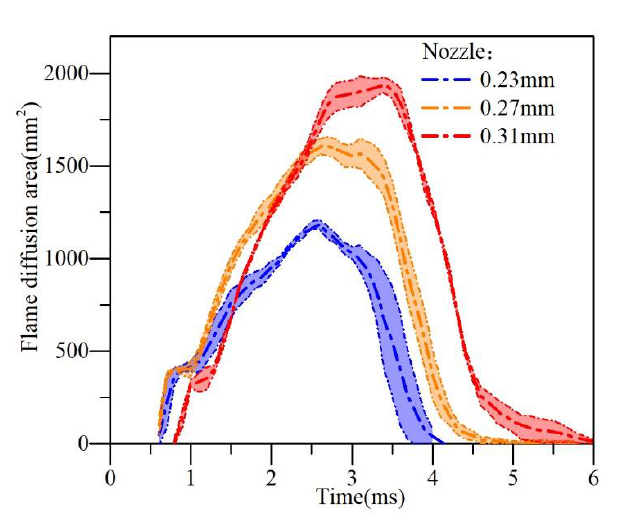
Figure 15. Flame di ff usion Figure 15. Flame diffusion area.